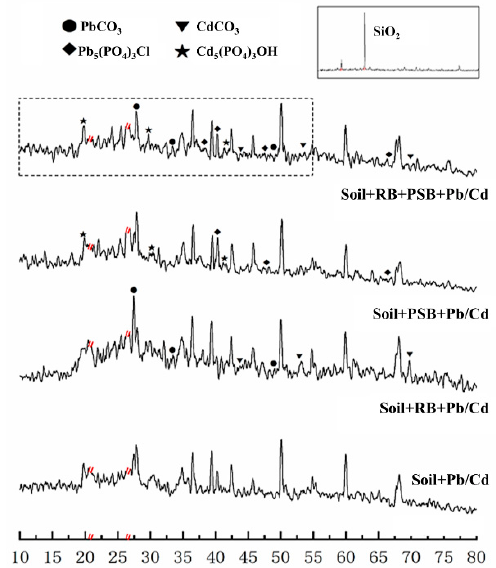
Figure 4. XRD patterns of various treatments (RB—rice husk biochar, PSB— Enterobacter sp.). All the patterns have been baseline-corrected and no pattern smoothing was performed. In order to avoid the strong quartz peak affecting the existence of other Pb-mineral peaks, we removed the range of the quartz peak at 20.6–21.9° and 26.5–26.9° (quartz at 21.3° and 26.7°).